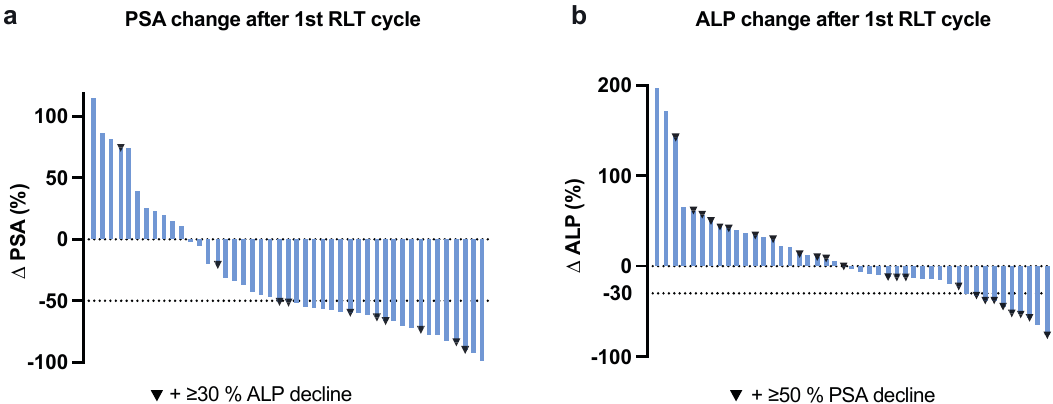
Figure 1. Waterfall plots indicating ( a ) PSA and ( b ) ALP response after first RLT cycle.